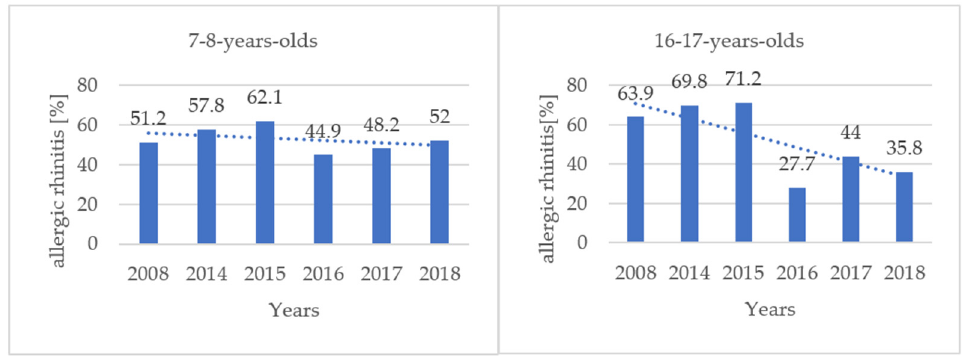
Figure 2. Incidence of allergic rhinitis in examined groups (seven to eight years, 2066 patients, regression coefficient = − 0.120; p = 0.879 and 16–17 years, 763 patients, regression coefficient = − 0.571; p = 0.236) in 2008–2018 (2009–2013 non tested).